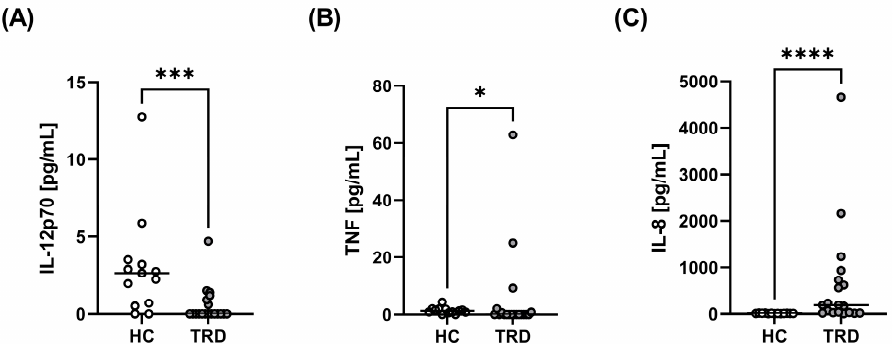
Figure 3. Comparison of serum concentrations of IL-12p70 ( A ), TNF- α ( B ), and IL-8 ( C ) between TRD patients and healthy people. The line represents the median according to two-tailed Mann–Whitney U test; * p < 0.05, *** p < 0.001, **** p < 0.0001. Table 2. Comparison of T-cell subpopulations and cytokine levels between TRD patients and healthy people.